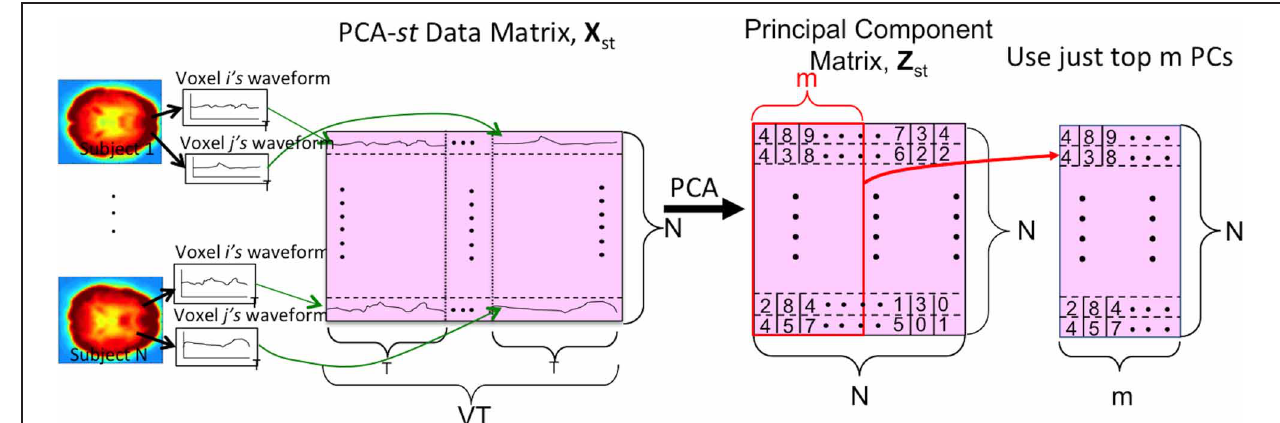
the input signal was always the 3 × 3 × 3 reduced version within the masked sub-volume. For some tests ( Figure 2 ), the “waveform” used to form the PCA- st matrix wasthe FFT of the original waveforms. Note that we can replace the first step, PCA, with kernel-PCA (kPCA) to represent the kPCA- st